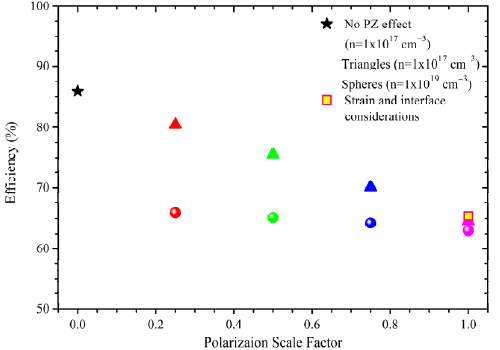
Figure 10. Effect of the stress relaxation and piezoelectric mitigation in the power conversion efficiency of the structure.